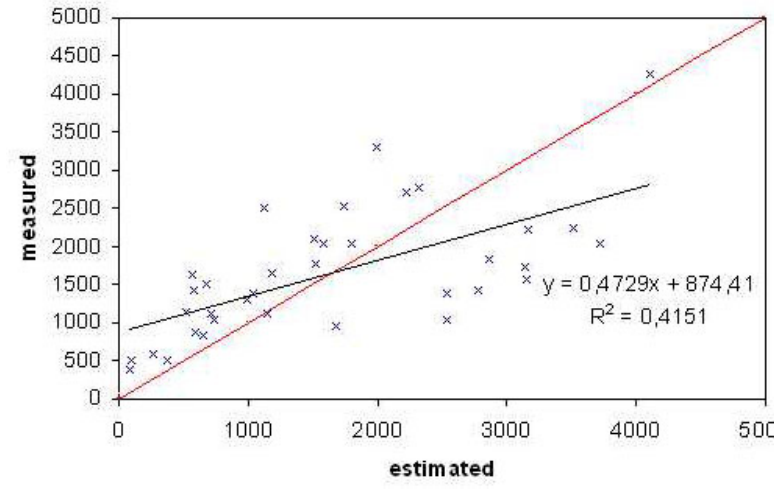
FIGURE 6. Measured vs. estimated AOT40